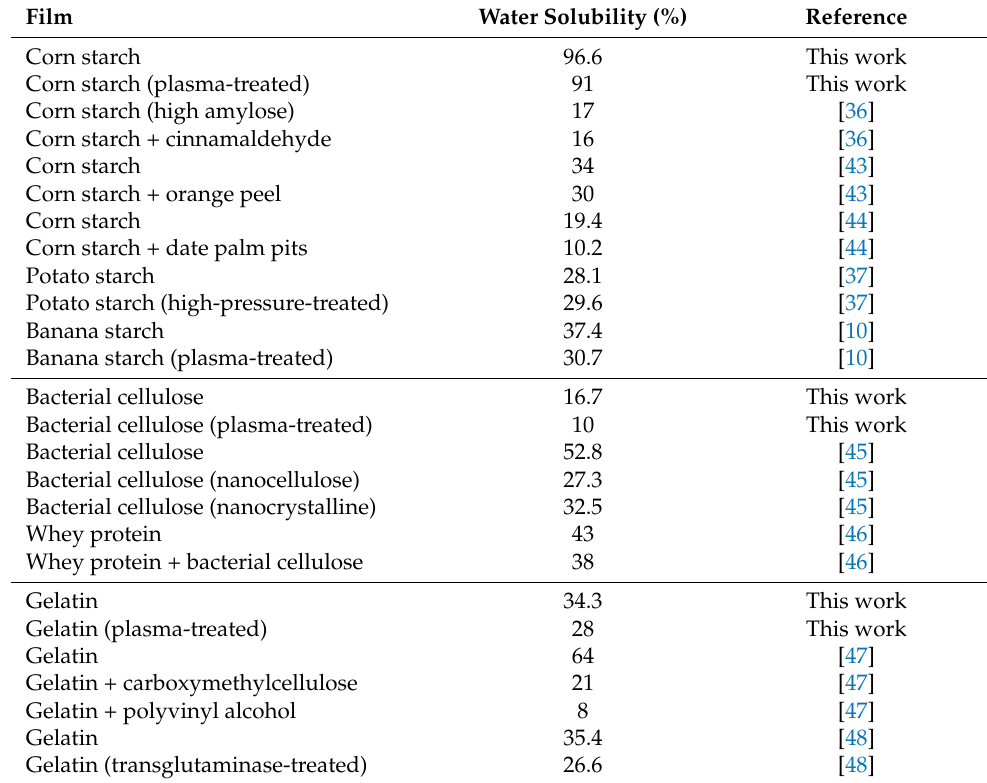
Table 6. Solubility of several starches, bacterial cellulose, and gelatin films reported in the literature. Film Water Solubility